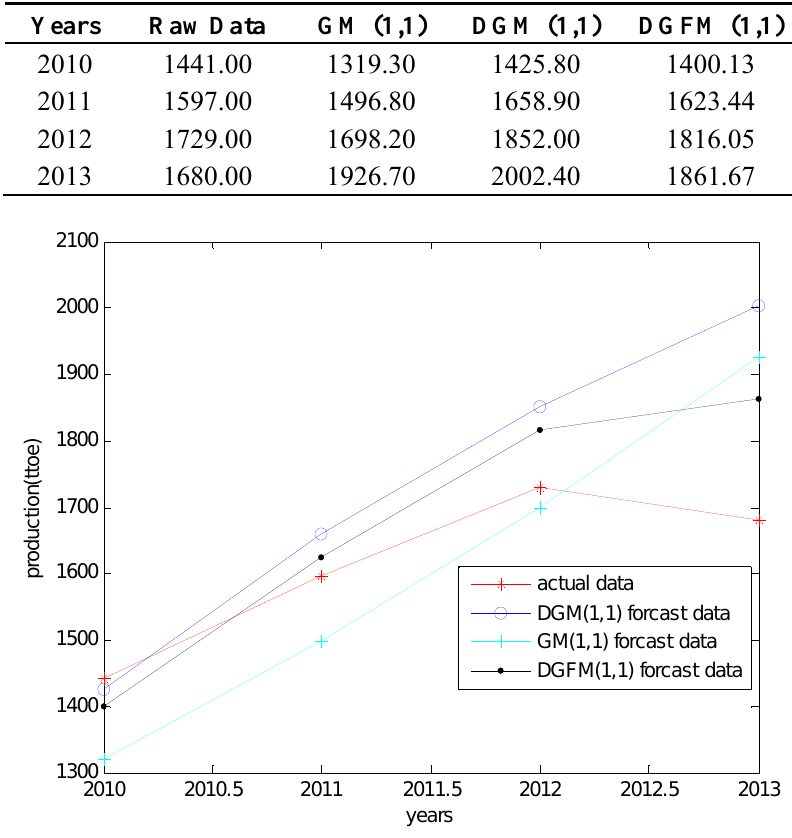
Figure 6. Comparison map of the three models and actual data.